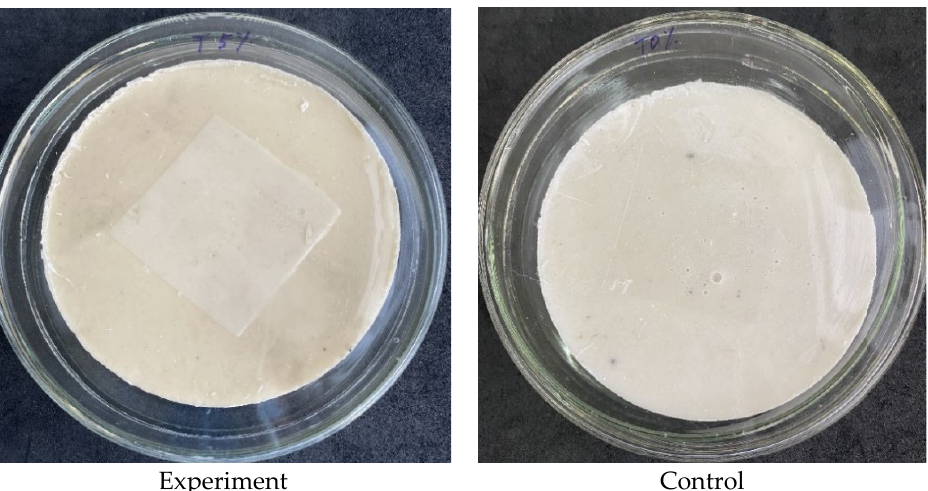
Figure 2. Inoculated experimental (with 5 wt.% Triclosan) and control (without Triclosan) composite samples covered with the release liner.